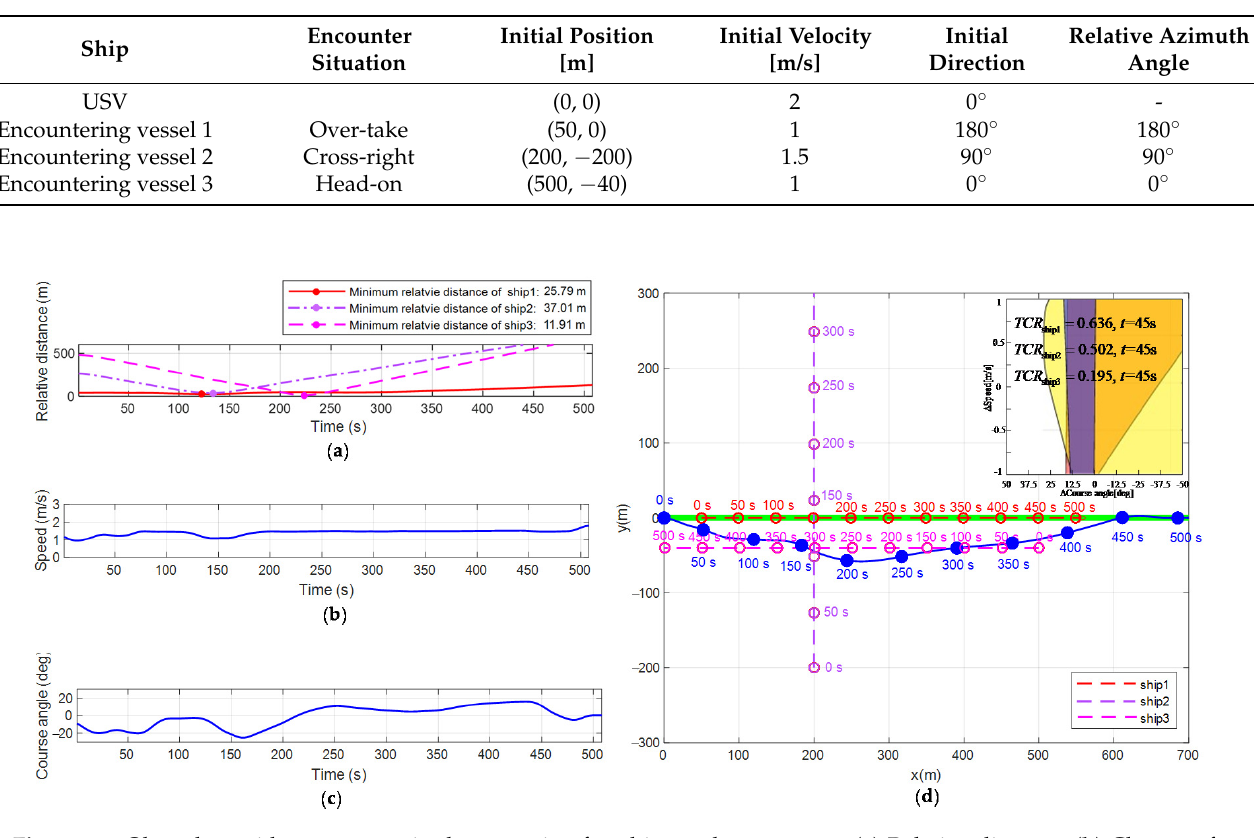
Figure 13. Obstacle avoidance process in the scenario of multi-vessel encounters. ( a ) Relative distance; ( b ) Change of velocity; ( c ) Change of yaw angle; ( d ) Obstacle avoidance